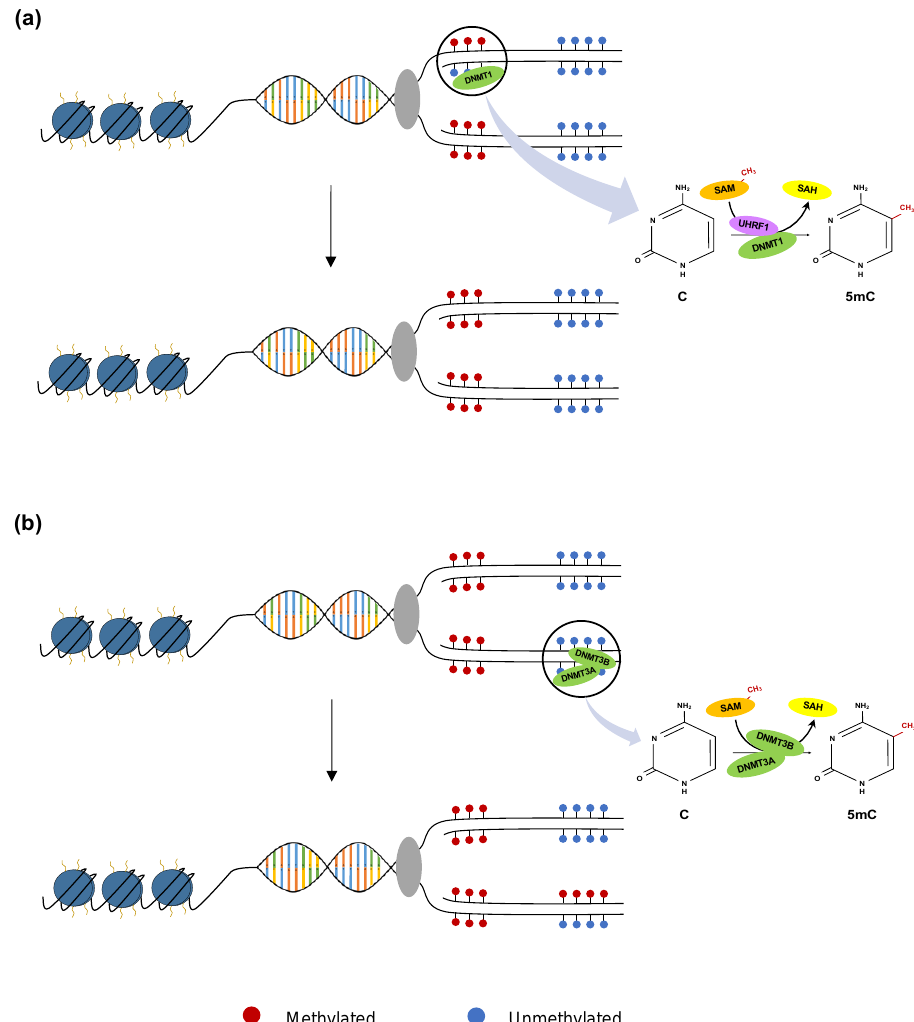
Figure 1. Regulation of the DNA methylome by methyltransferase enzymes ( a ) Maintenance of methylation. Shown is the action of DNA methyltransferase (DNMT)1 (green) at the replication fork catalyzing the methylation of hemimethylated DNA during replication. Ubiquitin-like containing PHD and RING finger domains 1 (UHRF1) (purple) acts as an important co-factor in the recruitment of DNMT1. S-adenyl methionine (SAM) acts as a donor of the required methyl group and is converted to S-adenosyl homocysteine (SAH) during the addition of methylation (CH3) marks (red) ( b ) De novo methylation. Shown are the replication-independent de novo methyltransferases, DNMT3A and DNMT3B, catalyzing the addition of new methylation marks at previously unmethylated cytosine-guanine dinucleotide (CpG) sites. SAM is shown as the methyl group donor for the conversion of cytosine to 5-methylcytosine (5mC).